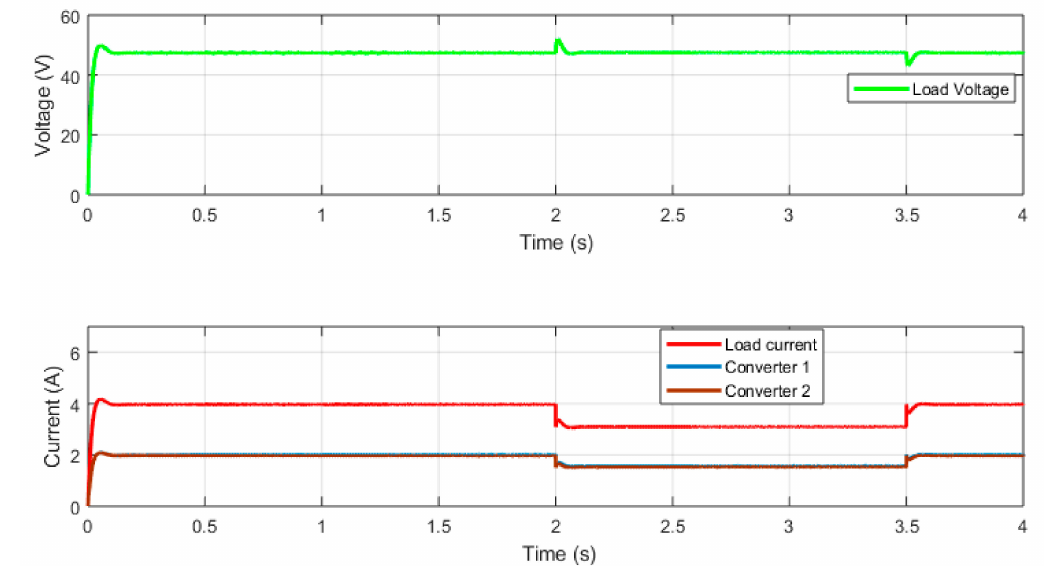
Figure 13. Simulation results for variation in load with different cable resistances for proposed droop control: load voltage, converter output currents and load current.